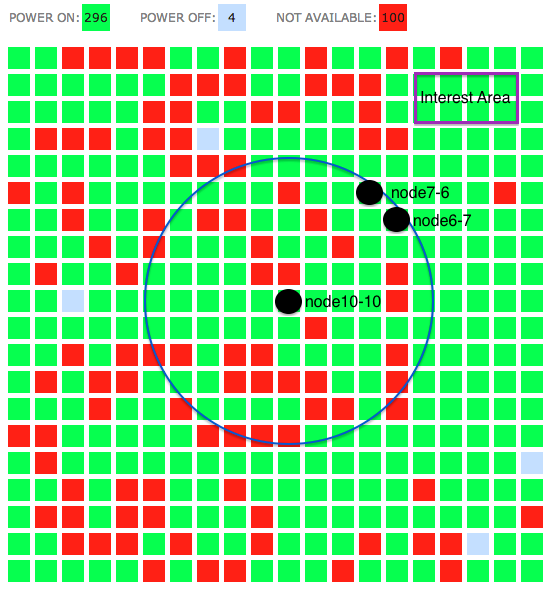
Figure 5. Open-Access Research Testbed (ORBIT) Experiment